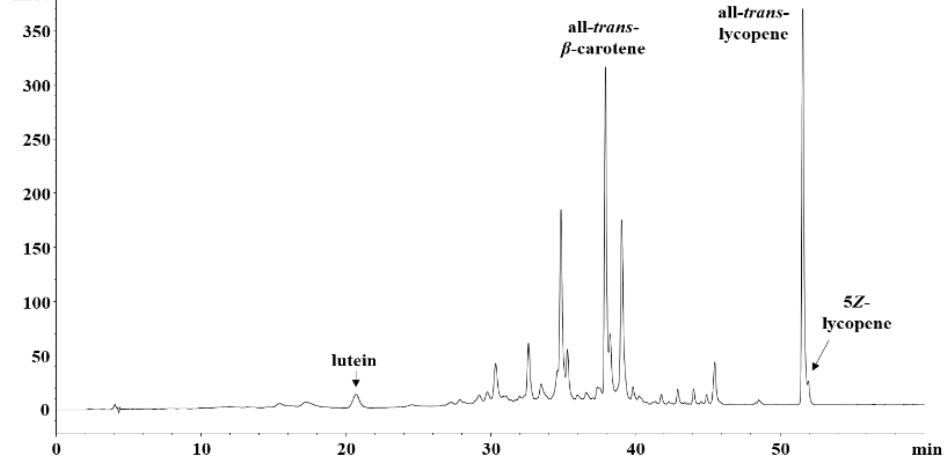
Figure 2. LC chromatogram of the lipophilic extract from a tomato cultivar, Dafnis (450 nm). α -, γ -, and δ -tocopherols are the major types of tocopherols present in the 18 tomato cultivars. α -Tocopherol was the most abundant among the three, followed by γ - and δ -tocopherols. The two small yellow cherry tomatoes showed the highest α -tocopherol (61.8 and 58.3 µ g/g) and total tocopherol contents (65.9 and 63.3 µ g/g). The mean values of α -,